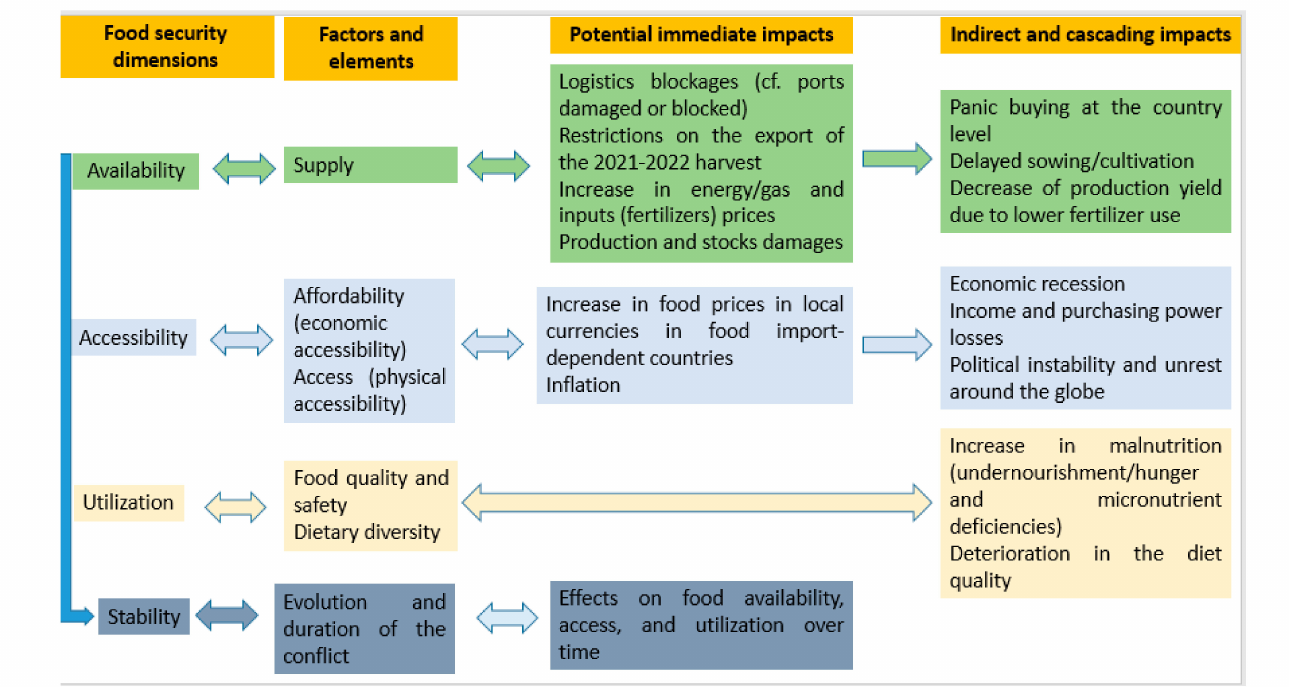
Figure 1. Impacts of the Russia–Ukraine war on global food security. Source: Authors’